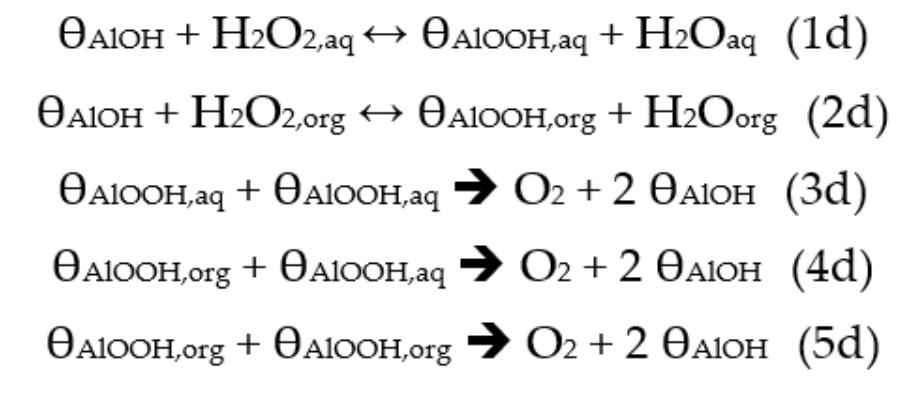
Figure 7. Oxidation mechanism.